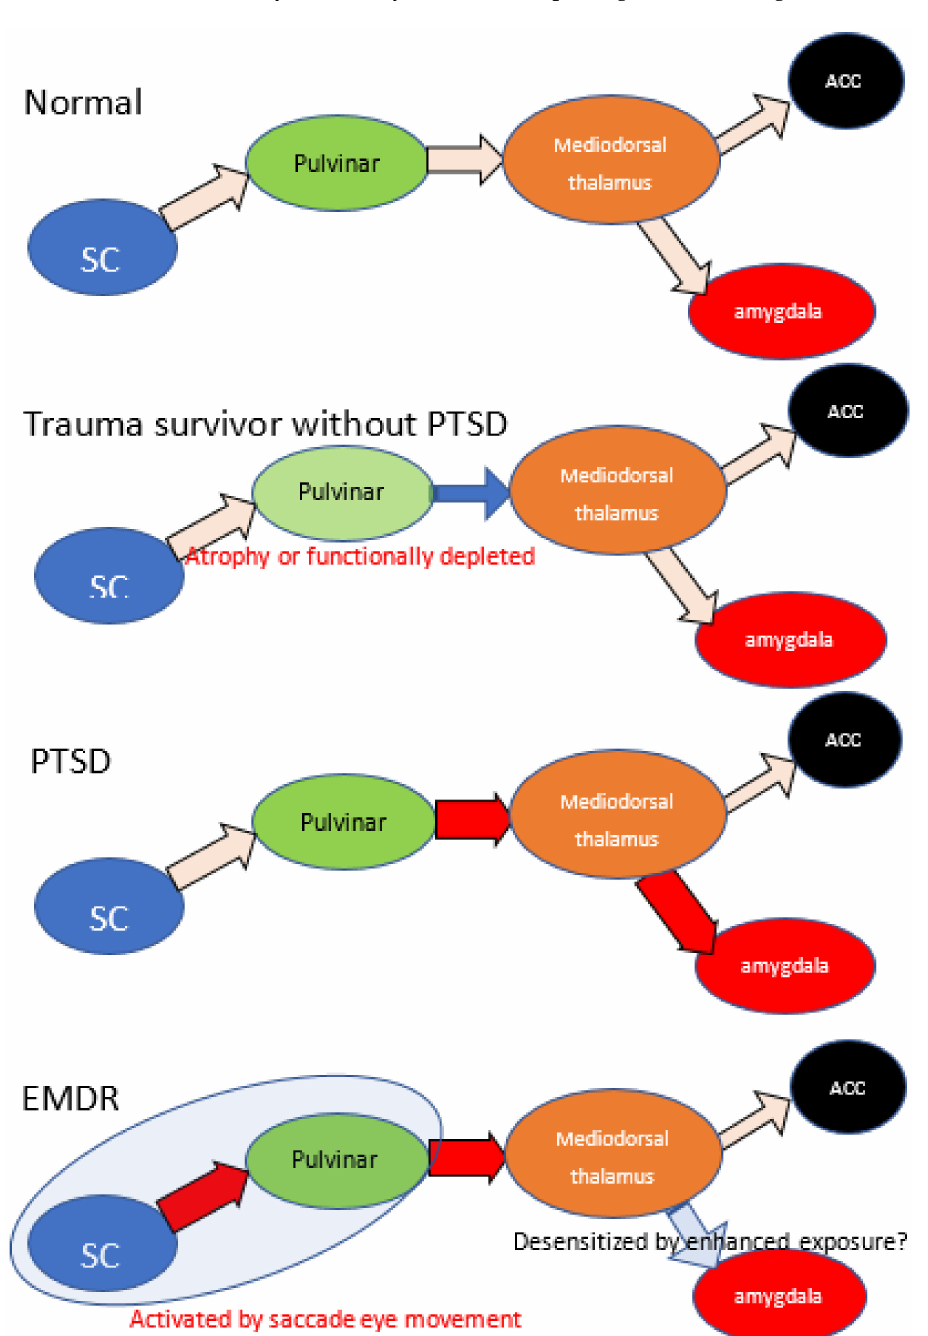
Figure 5. The schematic summary of retinotectal pathway and hypothetic mechanism of EMDR. Because of reports low morbidity rate of trauma survivors with smaller pulvinar, atrophy or dysfunction of pulvinar may have brought prevention of progression in PTSD. PTSD patients indicate enhanced connectivity between thalamus and amygdala, depleted between thalamus and ACC. EMDR intervention enhances the activity of retinotectal pathways and promotes the effects of exposure. Red arrow indicates enhanced connectivity and blue arrow indicate reduced. SC: superior colliculus, ACC: anterior cingulate